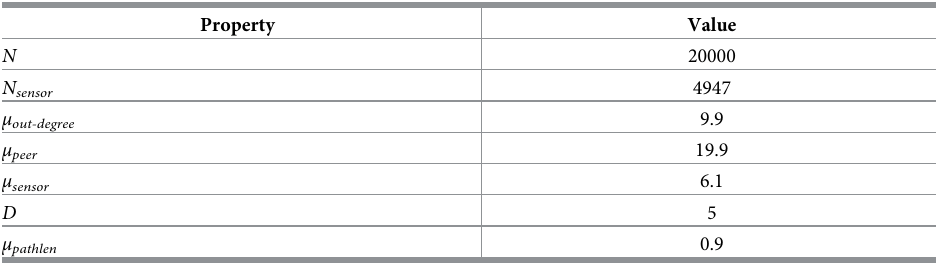
Table 2. Properties of the constructed P2P botnet.